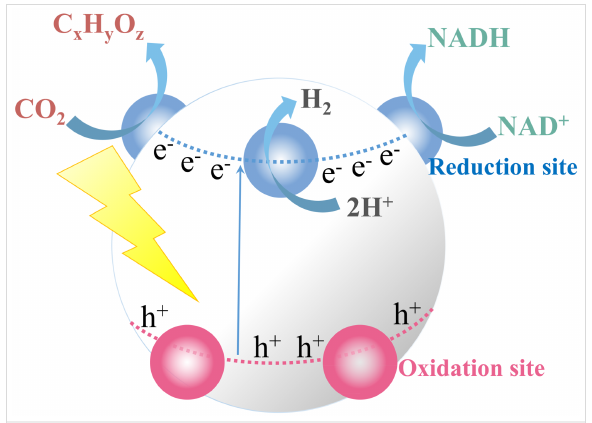
Figure 2: Basic principles and reactions in artificial photosynthesis, in which the processes of water splitting, CO 2 reduction and coenzyme regeneration all utilize electrons on the reduction